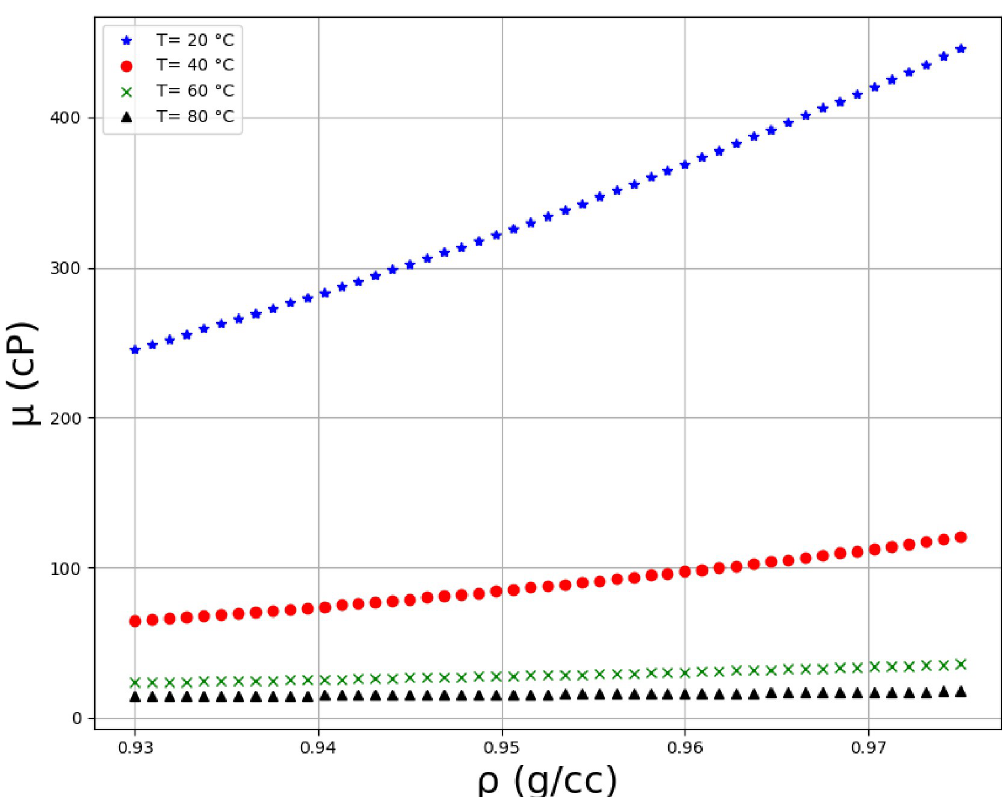
Fig 13. Trends of density on multiple temperature levels (API = 18.6, %C4 = 0.35, %C5 = 1.62, %C6 = 3.21, %C7+ = 94.81, SGC7+ =